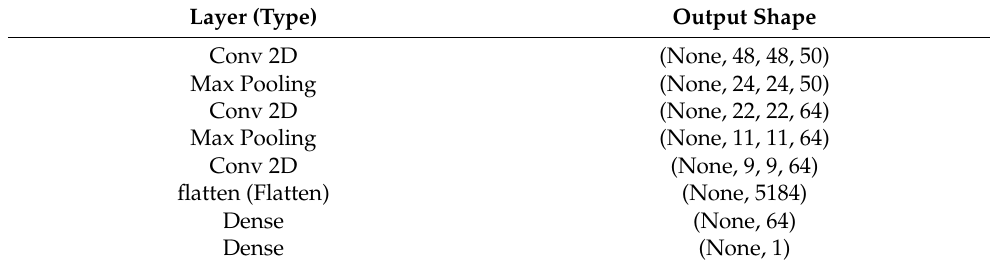
Table 1. CNN structure.